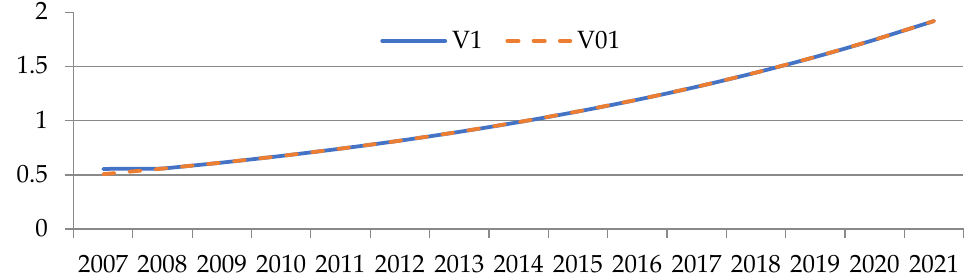
Figure 7. Graphs for tracking the target revenue indicator for industry No. 1 (author’s results).